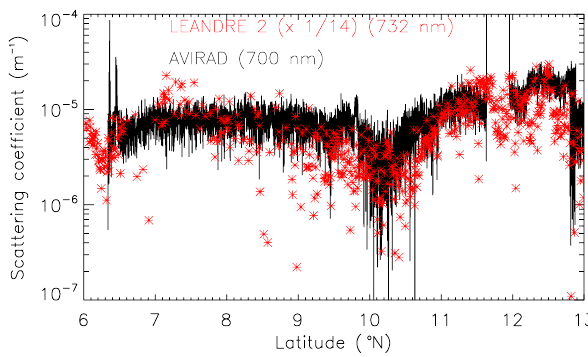
Fig. 2. Aerosol scattering coefficient at 730nm derived from LE- ANDRE 2 (between 0 and 180 ◦ ) at 700m m.s.l. (red symbols) and Fig.2. Aerosolscatteringcoefficientat730nmderivedfromLEANDRE2(between0and180 ◦ )at700mm.s.l.(redsymbols)andaerosol aerosol scattering coefficient derivd from AVIRAD (between 90 and scatteringcoefficientderivdfromAVIRAD(between90and180 ◦ )at700nm(blacksolidline).LEANDRE2dataaredividedbyafactorof 14withrespecttotheAVIRADdata(seetextfordetails). 180 ◦ ) at 700nm (black solid line). LEANDRE 2 data are divided by a factor of 14 with respect to the AVIRAD data (see text for